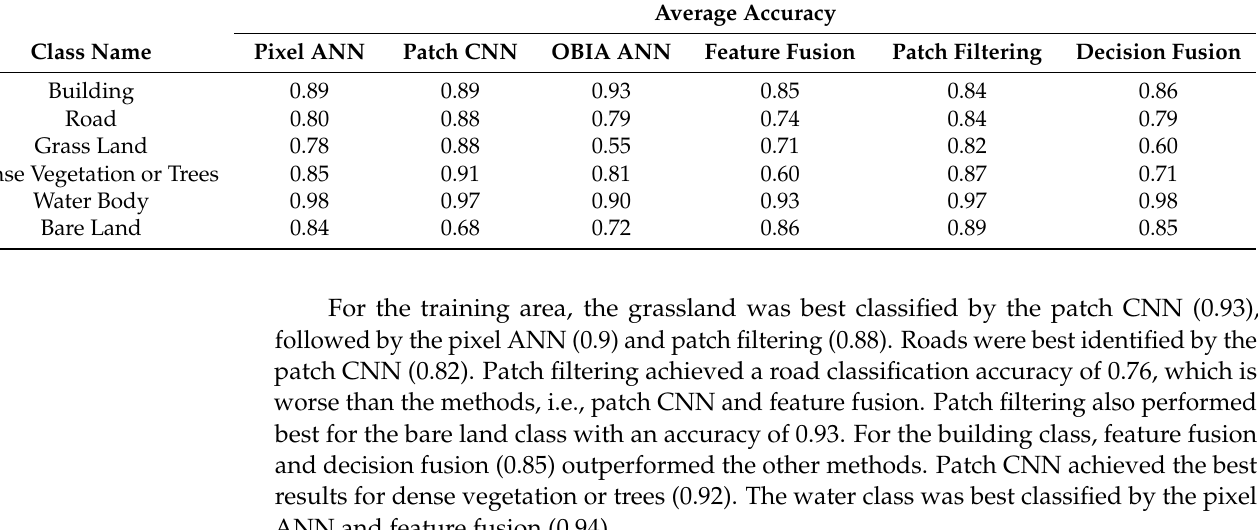
Table 7. Per-class accuracies obtained for each classification method using the test area dataset. Average